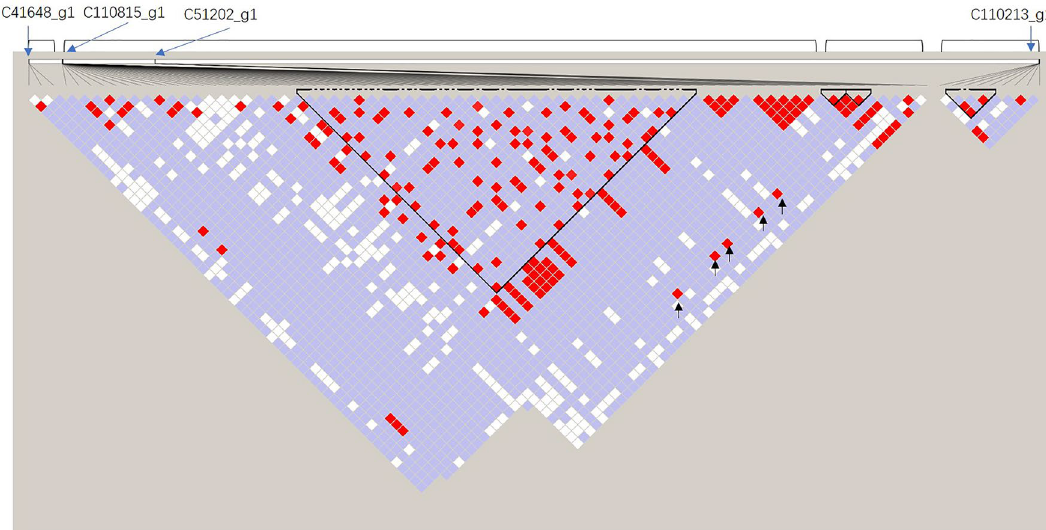
Figure 8. Linkage disequilibrium (LD) plot among C41648_g1, C110815_g1, C51202_g1 and C110213_g1. The color for each box in the LD plot represents the LD relationship, showing increasing LD from white to